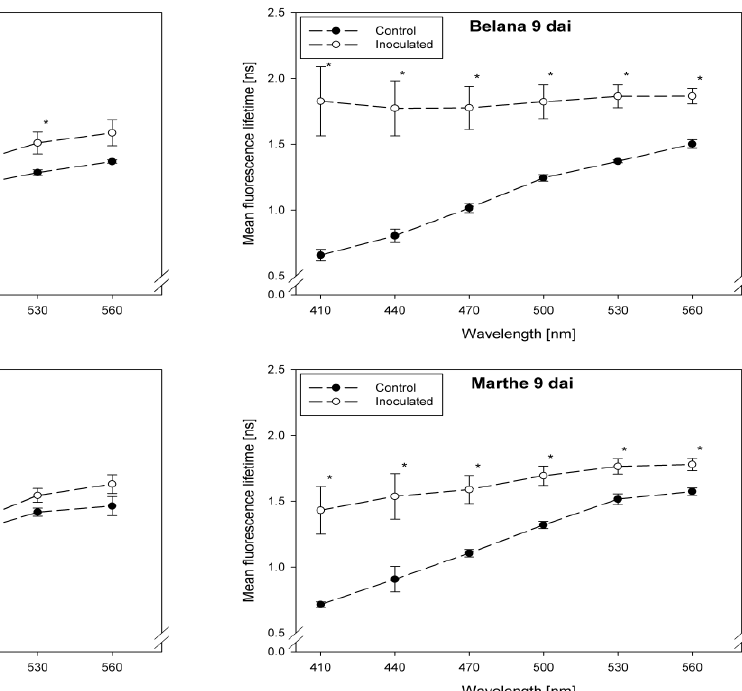
Figure 2. Mean fluorescence lifetime at selected wavelength (410–560 nm) of control and leaf rust inoculated leaves of the barley varieties Belana, Marthe, Conchita and Tocada (from top to bottom) at 3 and 9 days after inoculation (dai). Values indicate mean ± standard error ( n = 5). Significant differences ( t -test *, p ≤ 0.05) between control and inoculated leaves for each variety, wavelength, and measuring day are